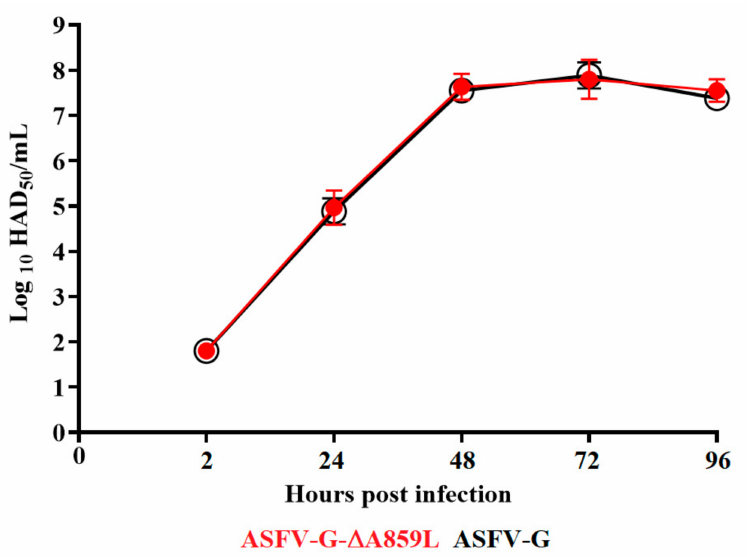
Figure 3. In vitro growth kinetics in primary swine macrophage cell cultures for ASFV-G- ∆ A859L and parental ASFV-G (MOI = 0.01). Samples were taken from three independent experiments at the indicated time points and titrated. Data represent the means and standard deviations of three replicas. Sensitivity using this methodology for detecting virus is ≥ log10 1.8 HAD 50 / mL . No significant differences in viral yields between viruses were observed at any time point tested determined using the Holm–Sidak method ( α = 0.05), without assuming a consistent standard deviation. All calculations were conducted using the software Graphpad Prism v8. Swine survival and fever response following infection with ASFV-G- ∆ A859L and parental